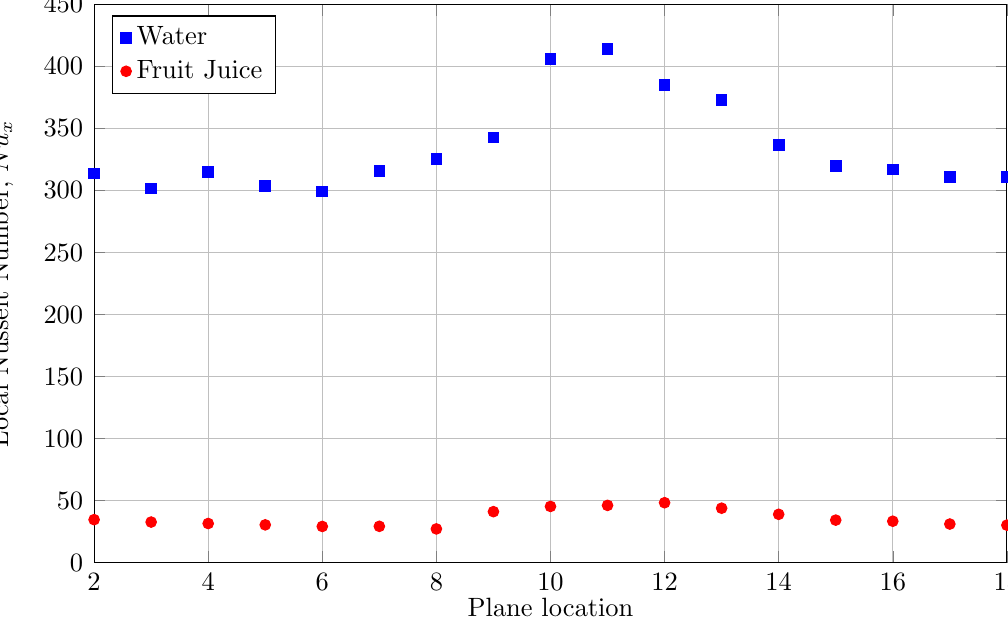
Figure 10. Local Nusselt number across the plane locations along the computational domain using fruit juice and